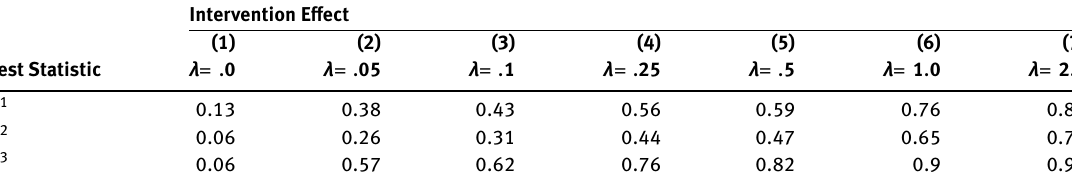
Table 2: Rejection Rates Using Only Units with a Good Pre-intervention